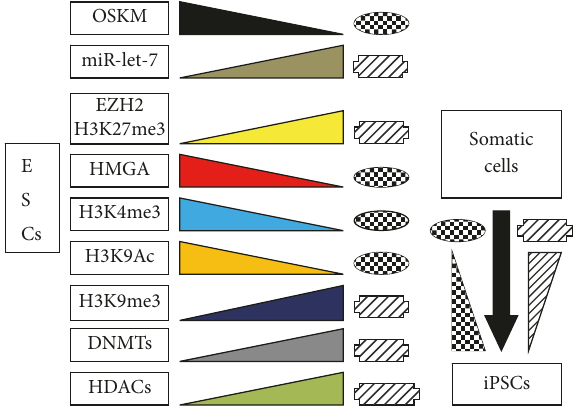
Figure 11: Changes in the action of factors from ESCs to somatic cell (coloured triangles) and reversed action (black arrow) from somatic cells to